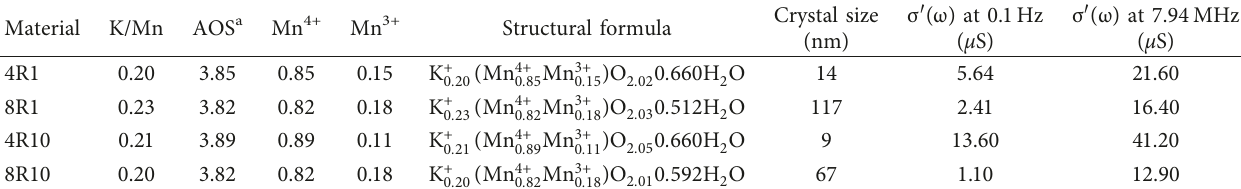
Figure 1: X-ray patterns for birnessites synthesized at 400 ° C and 800 ° C: (a) materials at 1 ° C/min heating rate, (b) zoom between 30 ° and 70 ° (2 θ ) for the materials at 1 ° C/min heating rate, (c) materials at 10 ° C/min heating rate, and (d) zoom between 30 ° and 70 ° (2 θ ) for the materials at 10 ° C/min heating Table 1: Physicochemical parameters and structural formulas of the synthesized materials.